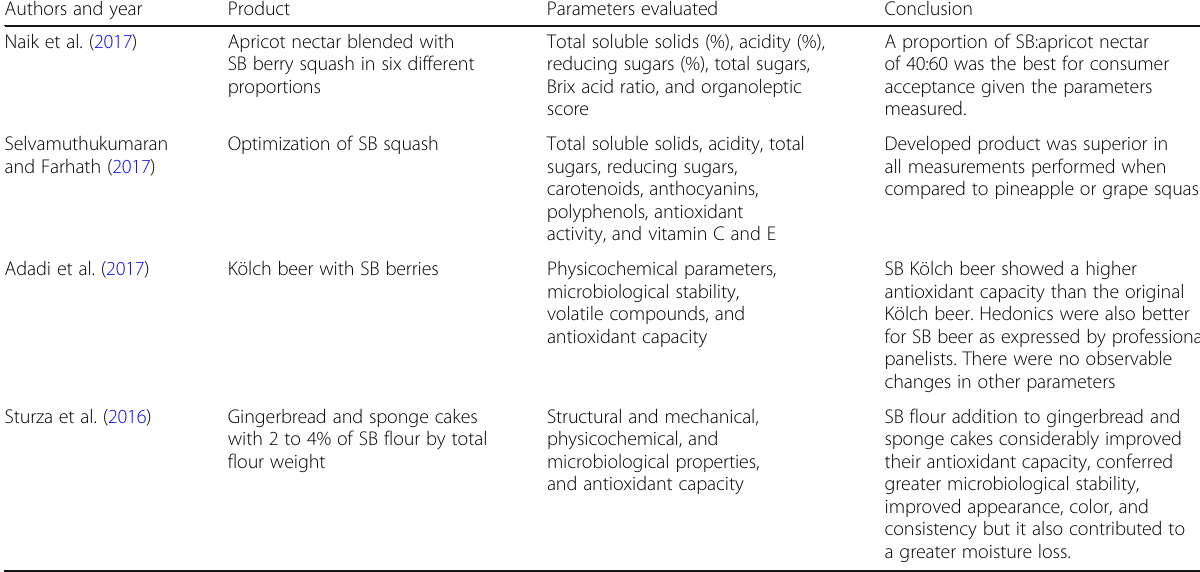
Table 1 Additional articles investigating SB-juice-based beverages and other fermented food